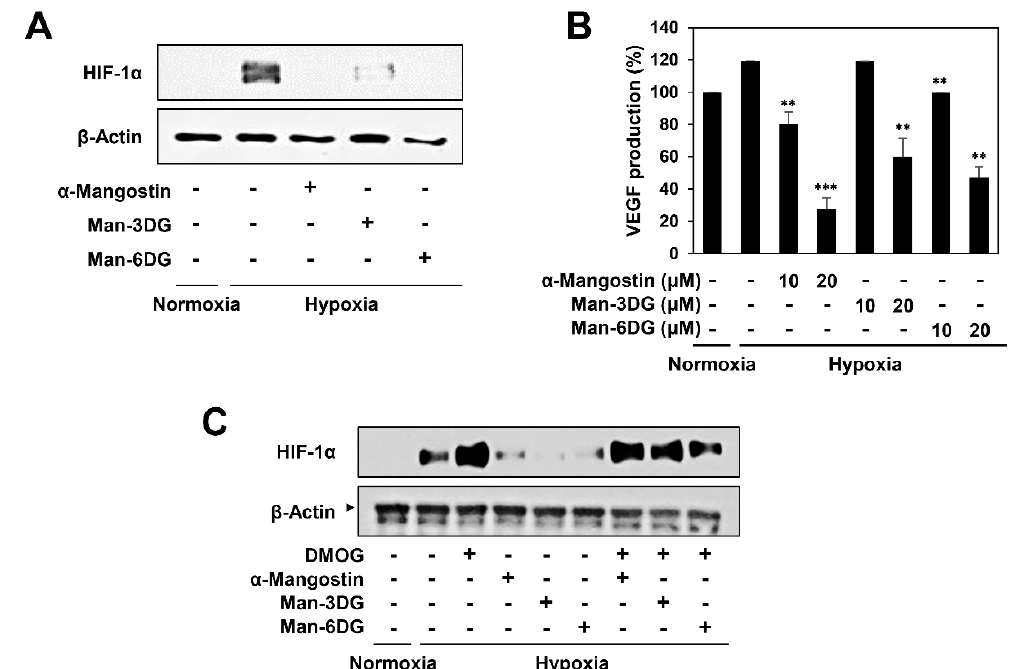
Figure 9. The e ff ects of α -mangostin glycosides on HIF-1 α activity in Hep3B cells. ( A ) The e ff ects of α -mangostin, Man-3DG, and Man-6DG on the HIF-1 α protein accumulation induced by hypoxia. Hep3B cells were pretreated with the three compounds (10 µ M) for 1 h and then exposed to 1% O 2 for 4 h. The protein levels of HIF-1 α were detected through western blot analysis. The levels of β -actin were used as an internal control. ( B ) The e ff ects of α -mangostin, Man-3DG, and Man-6DG on VEGF expression. Hep3B cells were pretreated with the three compounds (10 and 20 µ M) for 1 h and then exposed to 1% O 2 for 6 h. The concentration of vascular endothelial growth factor (VEGF) protein in the culture supernatant was determined through a VEGF specific ELISA. Each value represents the mean ± SD from three independent experiments. ** p < 0.01 and *** p < 0.001 versus the hypoxic control. ( C ) The e ff ects of α -mangostin, Man-3DG, and Man-6DG on the HIF-1 α protein accumulation in the presence or absence of dimethyloxalylglycine (DMOG). Hep3B cells were pretreated with the three compounds (10 µ M) and DMOG (1 mM) for 1 h and then exposed to 1% O 2 for 4 h. The protein levels of HIF-1 α were detected through western blot analysis. The levels of β -actin were used as an internal control.